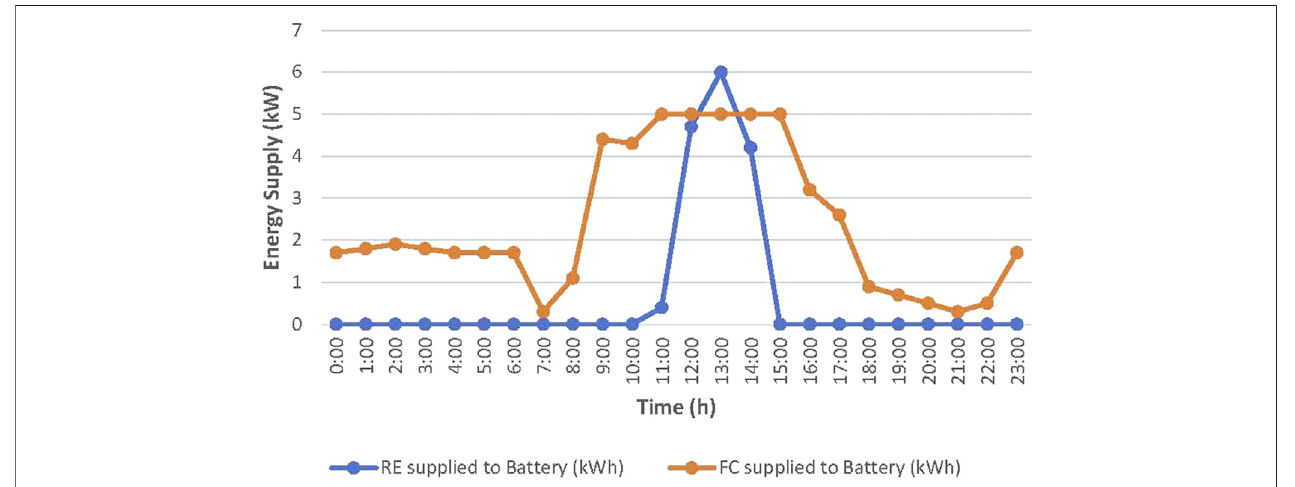
FIGURE 9 | Energy Supplied by the Renewable Energy and Fuel Cell to Charge the Battery in Day 2